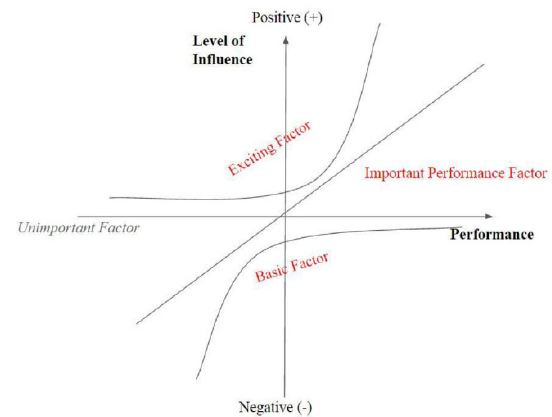
Figure 2. The method of categorization of three factors based on influence and performance [31] .